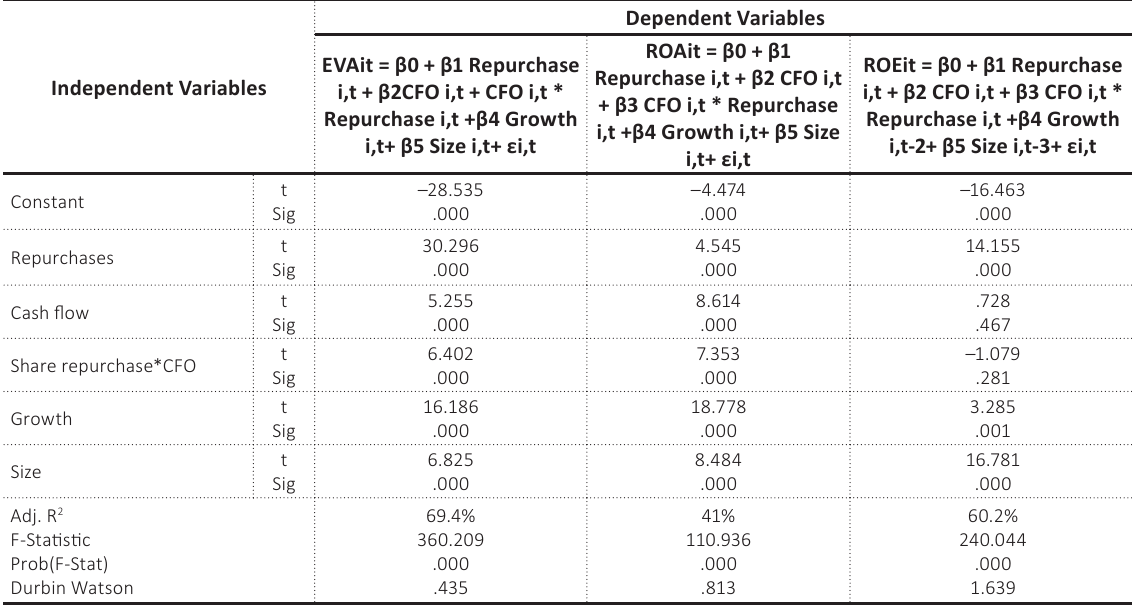
Table 6. The interactive effect of cash flows and share buyback on financial performance